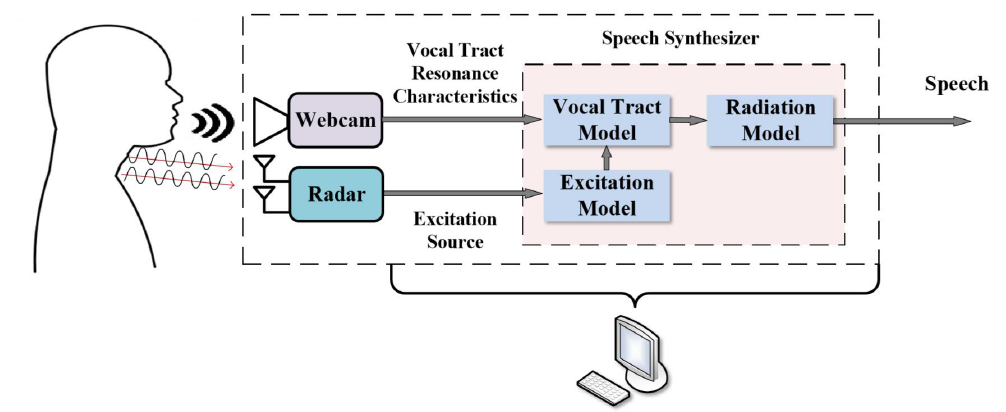
Figure 1. System framework of the